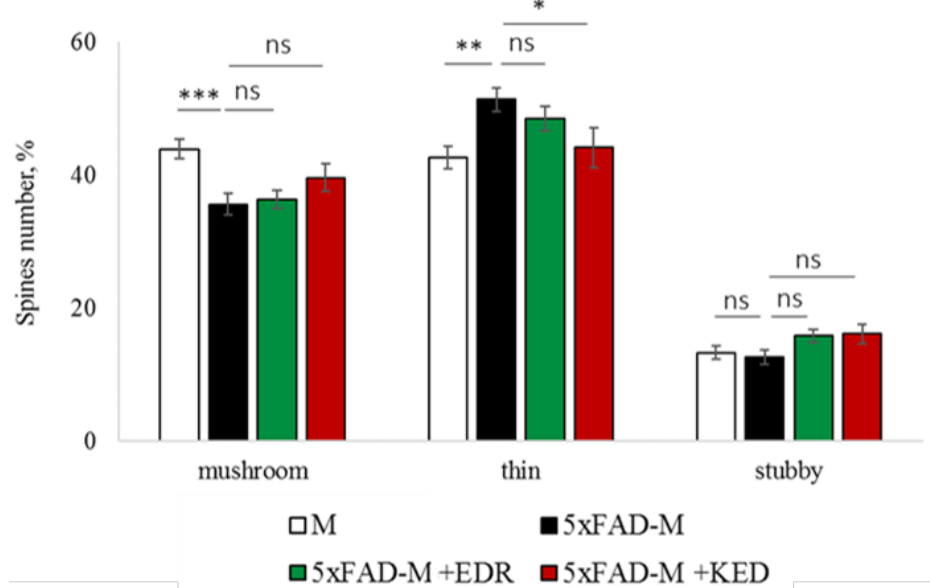
Figure 10. Relative mushroom spines number of CA1 secondary dendrites in 5 month-old female M and 5xFAD-M mice, injected with physiological solution, EDR peptide, KED peptide. *, **, ***— p < 0.05, p < 0.01, p < 0.001 compared to the control 5xFAD-M mice, injected with physiological solution, ns—non-significant.